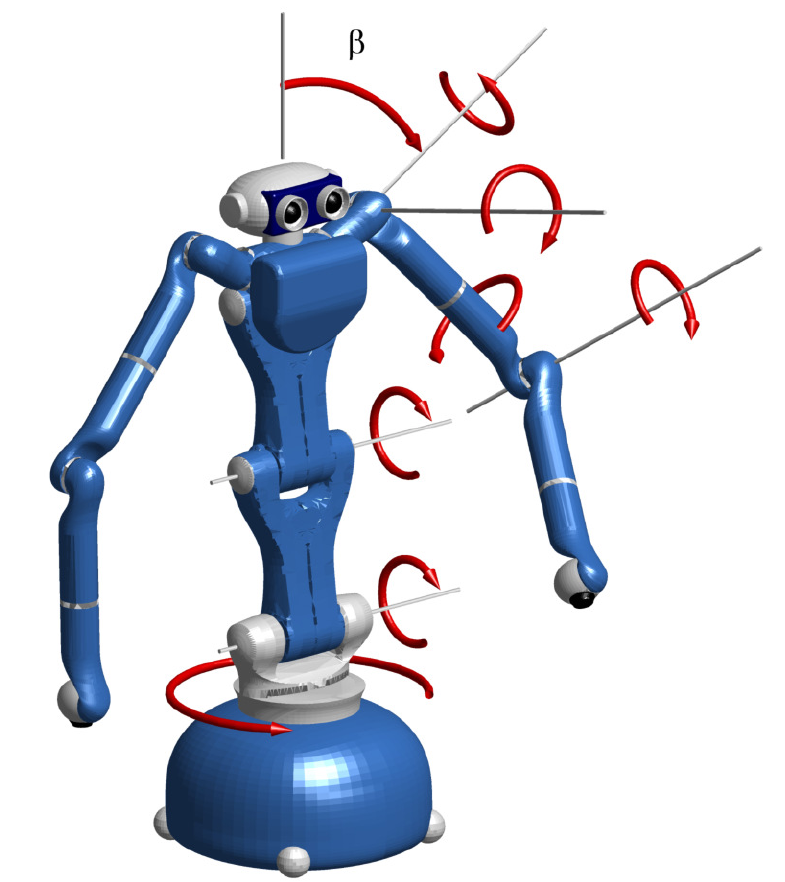
Figure 1. Model of the humanoid